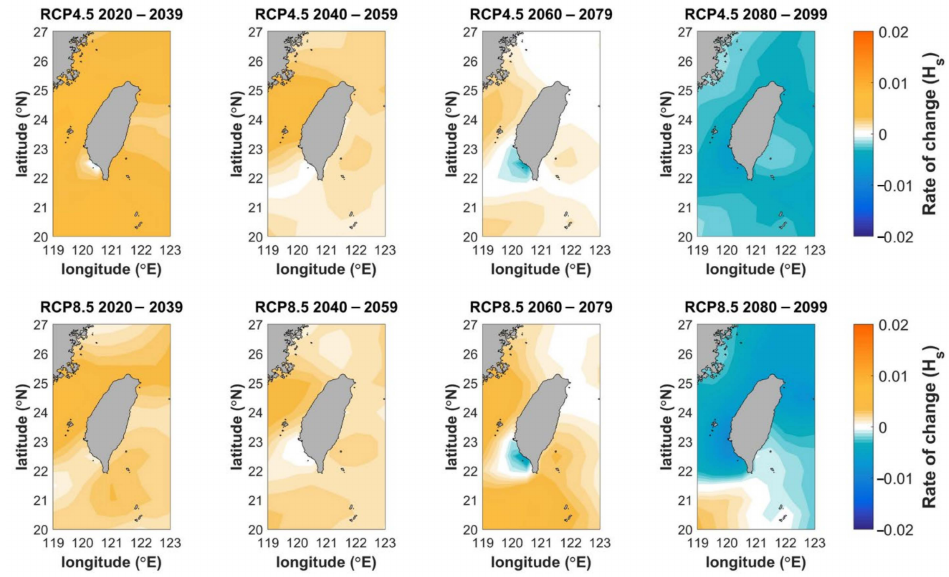
Figure 12. Rate of change in the annual mean of significant wave height of selected GCMs with respect to the reference period from 1980 to 2004 in the region of Taiwan for various future periods